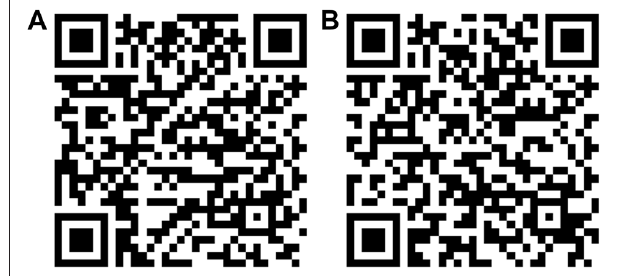
FIGURE 8 | The transparent brain is shown with seven connectivity networks (Yeo et al., 2011) and red spheres on the 10–20 EEG electrode positions. By touching a sphere, the name of the electrode appears on the upper left-hand corner of the screen (for example, T3).